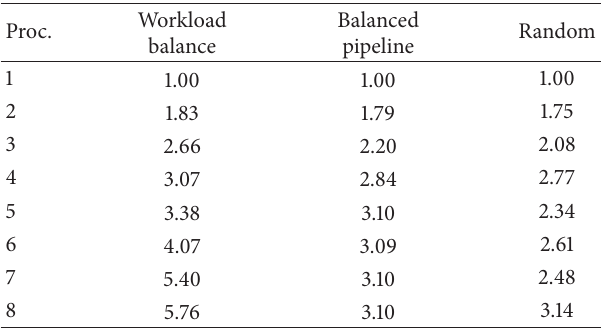
Table 1: Speed-up: greedy constructive